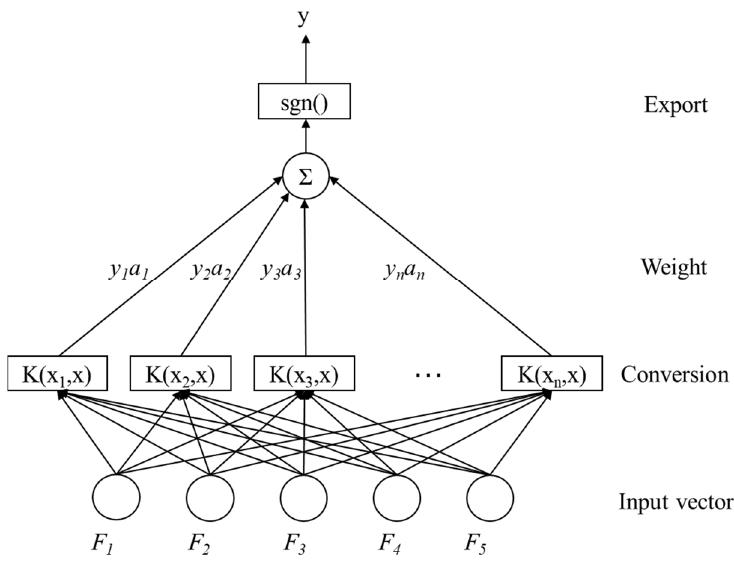
Figure 5. Flowchart of the support vector machine (SVM) method.